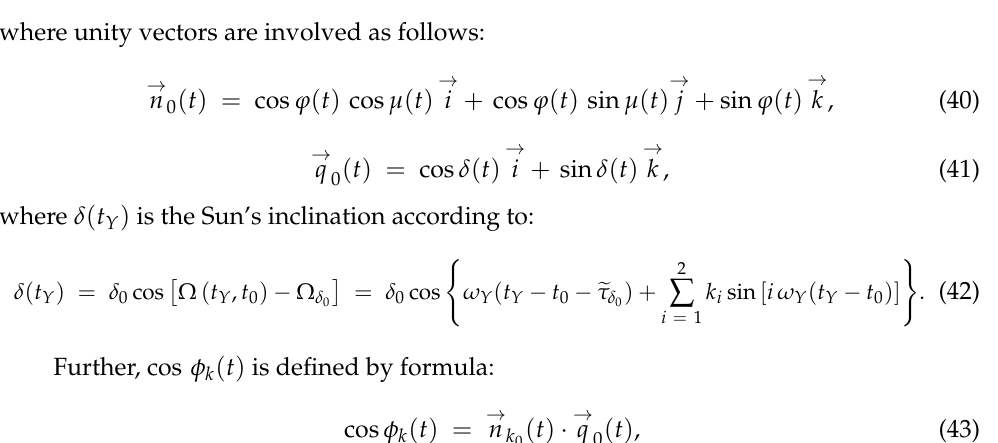
( b ) ϕ Ψ ( , ) . t and ( b ) 1. tc c r Y → ( t ) (Figure q 0